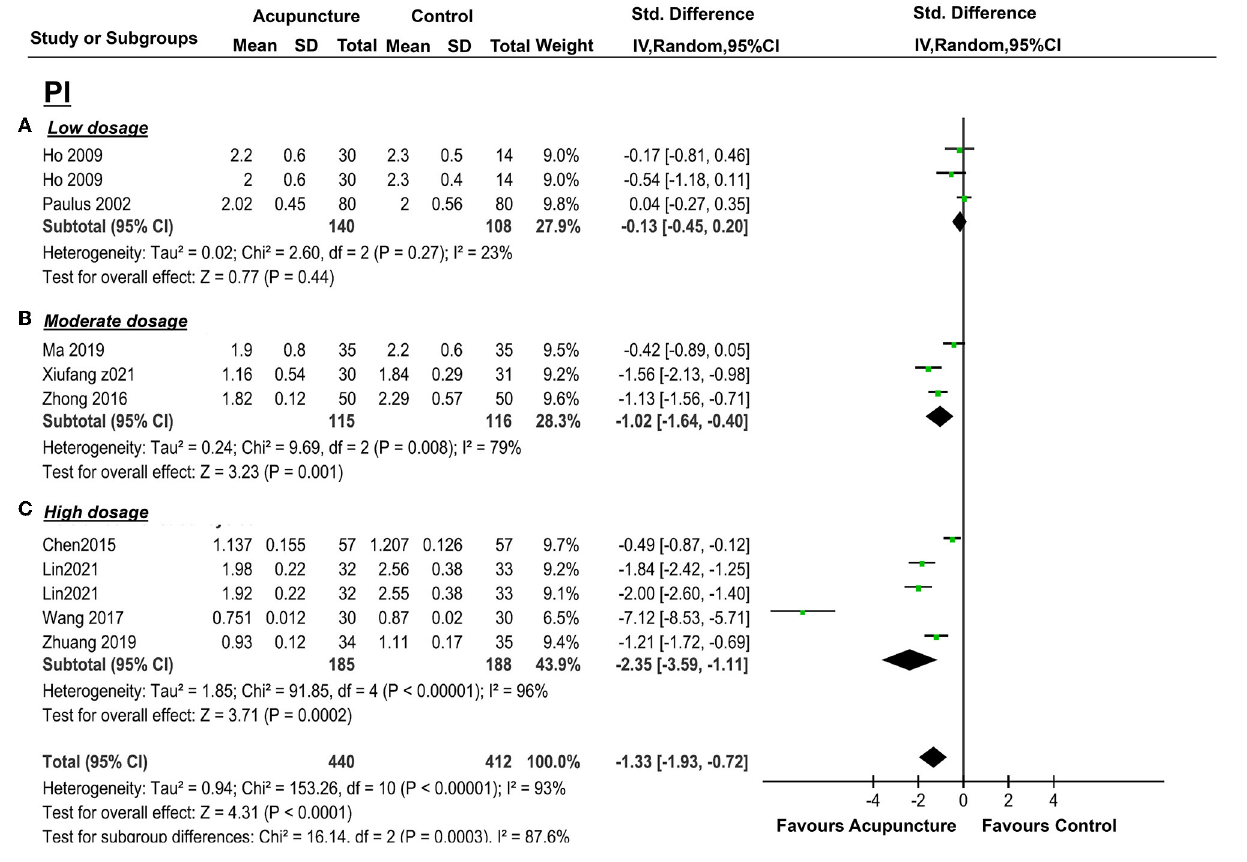
FIGURE 6 | Effects of acupuncture on PI based on intervention of low dosage (A) , moderate dosage (B) , and high dosage (C)